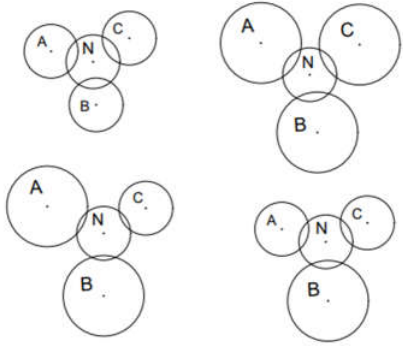
Figure 3. Nodes A, B and C are close to each other.